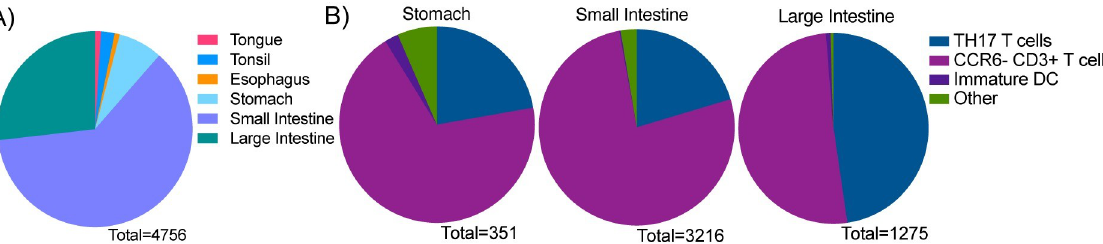
Fig 4. The majority of SHIV-1157ipd3N4 infected cells are T cells at 96 hours after oral challenge. Quantification of SHIV-1157ipd3N4 infected cells found in the oral cavity and GI tract of animals examined in Figs 3 and 4. Graphs depict the percentage of infected cell types identified by fluorescent microscopy as parts of a whole. Total cell counts were taken in five 40x panels in every animal. A) Total number of infected cells in all eight neonatal RMs in tongue, tonsil, esophagus, stomach, small intestine, and large intestine. B) Total number of infected cell phenotypes in all eight RMs in the stomach, small intestine, and large intestine. Infected cell types were categorized as five cell types: T cells (CD3+), TH17 T cells (CD3+, CCR6+), CCR6- CD3+ T cells, Immature DCs (CD3-, CCR6+), Other (CD3-,